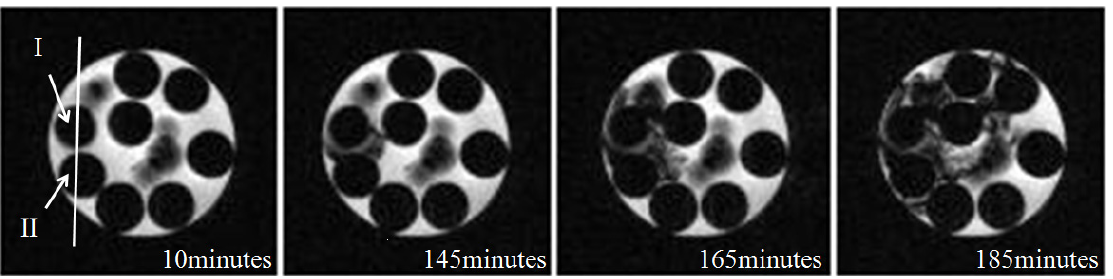
Figure 6. The images of the THF hydrate growth in one of the cross sections with time in 11.4% THF solution.